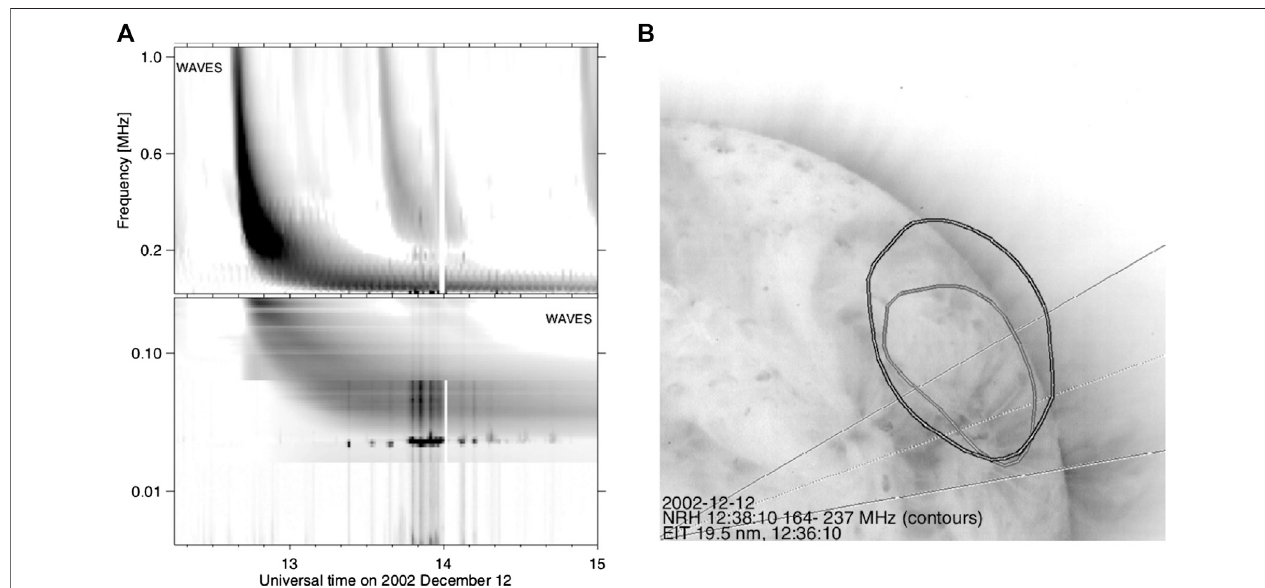
FIGURE 6 | Kilometric type III bursts and Langmuir waves as tracers of magnetic connection to the Sun on December 12, 2002: (A) Dynamic spectrum of radio emission between 1 MHz and a few kHz; (B) Superposition of radio sources (iso-intensity contours at half maximum) at 164 and 237 MHz on the EUV image (Klein and Posner, 2005). Sharply delimited rectangular gray areas and vertical bars on either side of the intense Langmuir waves in the spectra are instrumental artifacts. ©ESO. Reproduced with permission.